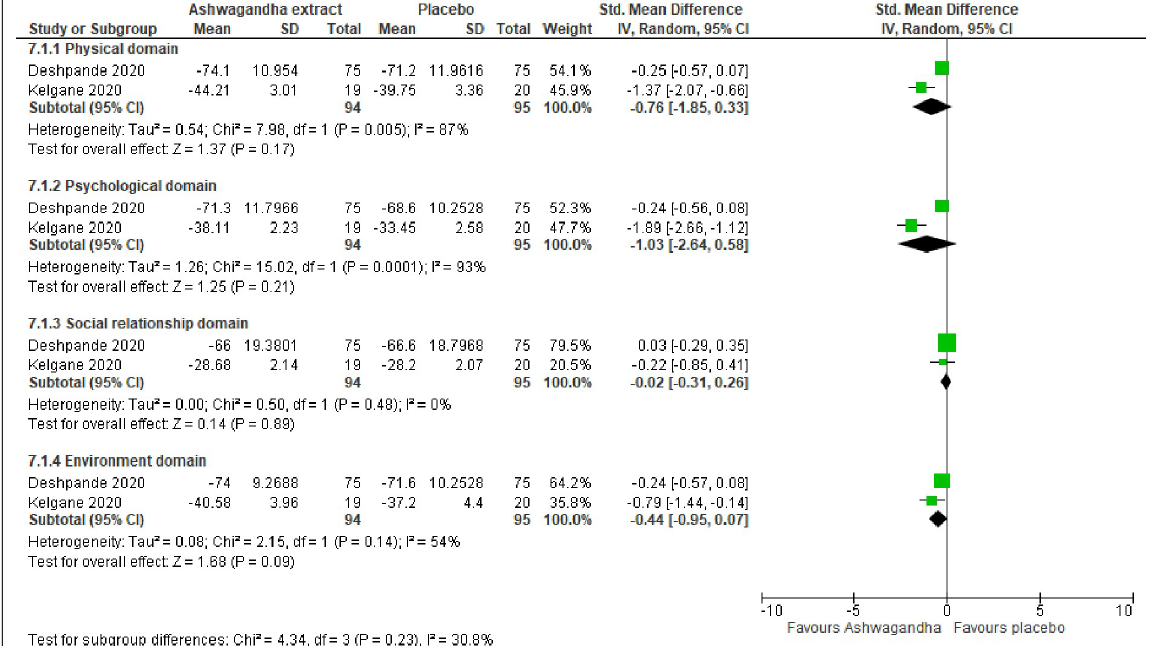
Fig 8. Forest plots of Ashwagandha versus placebo on quality of life.